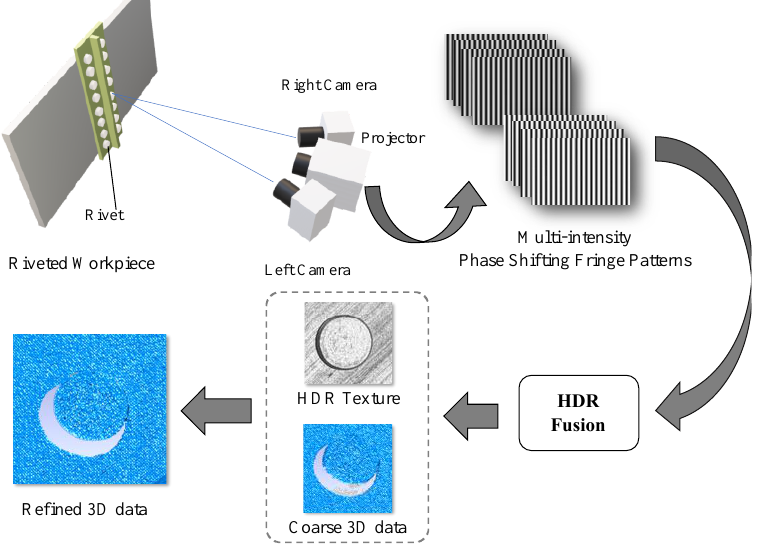
Figure 1. Scheme of the proposed method where an improved high dynamic range fringe projection profilometry (HDR FPP) method with texture constraint is used. The basic idea is to combine the 3-D FPP data with 2-D texture to achieve better performance on rivet inspection.